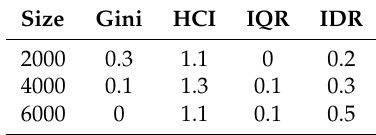
Table 3. Relative mean bias (%) of each parameter applying PSA with the proportional reference